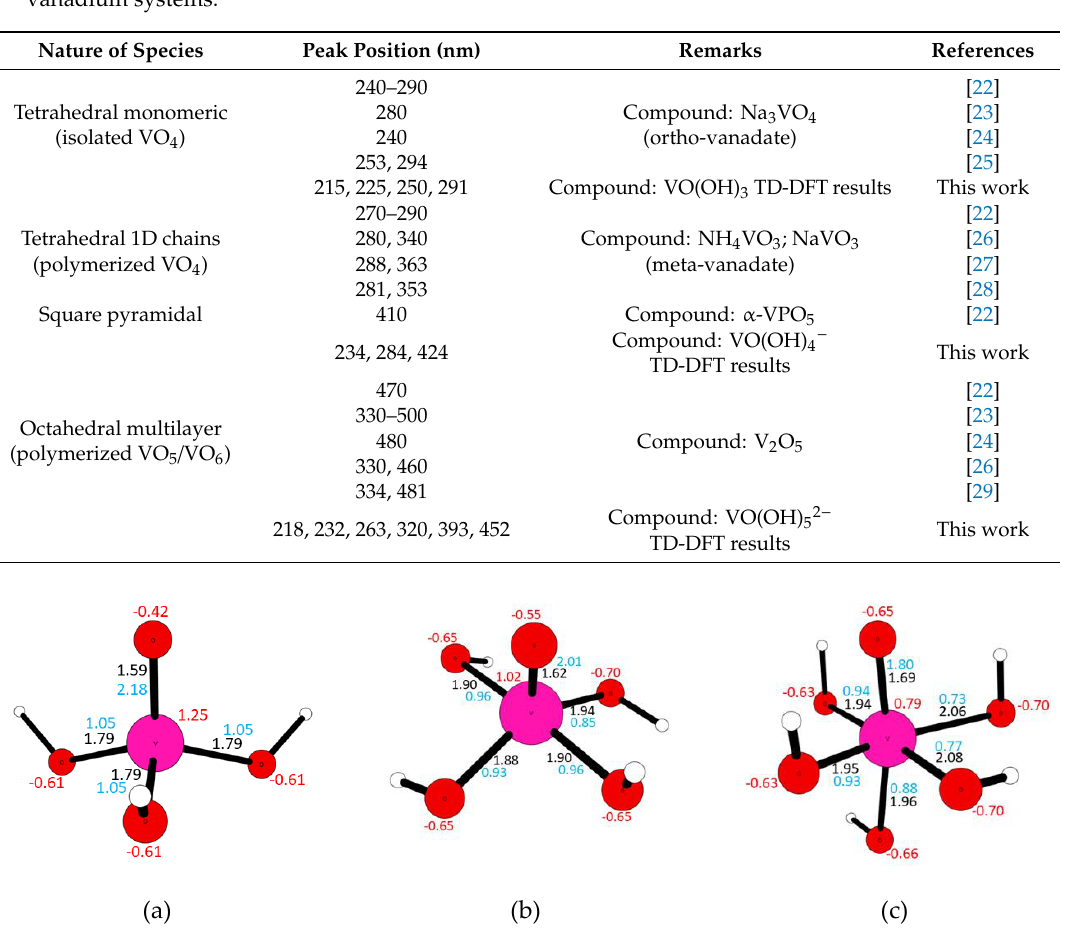
Table 3. Time-dependent density-functional theory (TDDFT) (PBE / def2-TZVP) absorption peak positions for model V compounds and the reference experimental UV-VIS peak positions for vanadium systems.